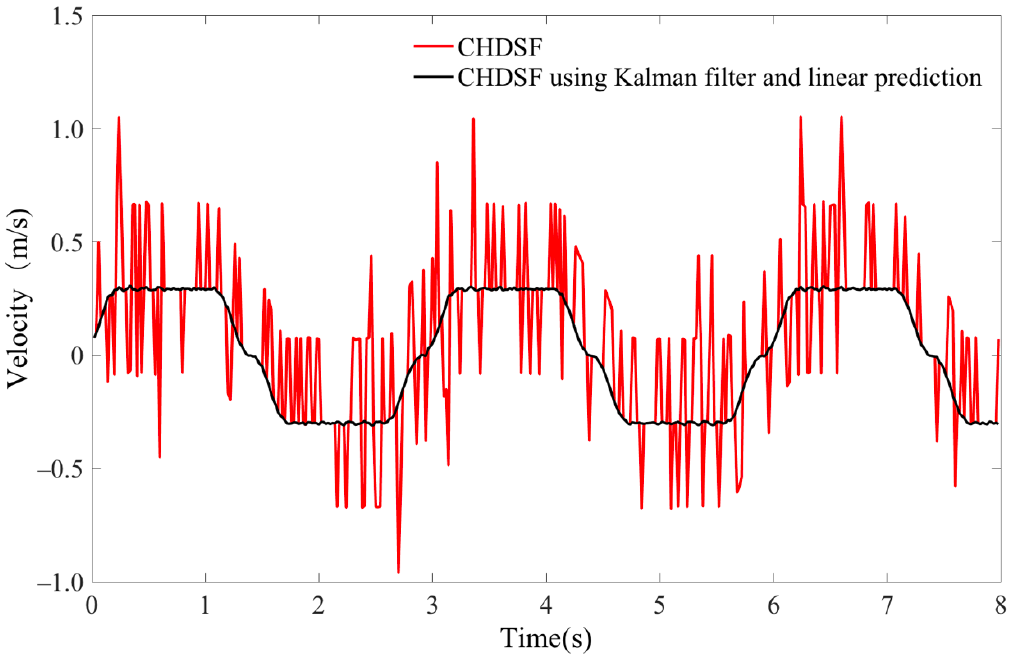
Figure 6. Velocity measured by CHDSF using the Kalman filter and linear prediction. Table 3. Parameters used in the Kalman filter and linear prediction.